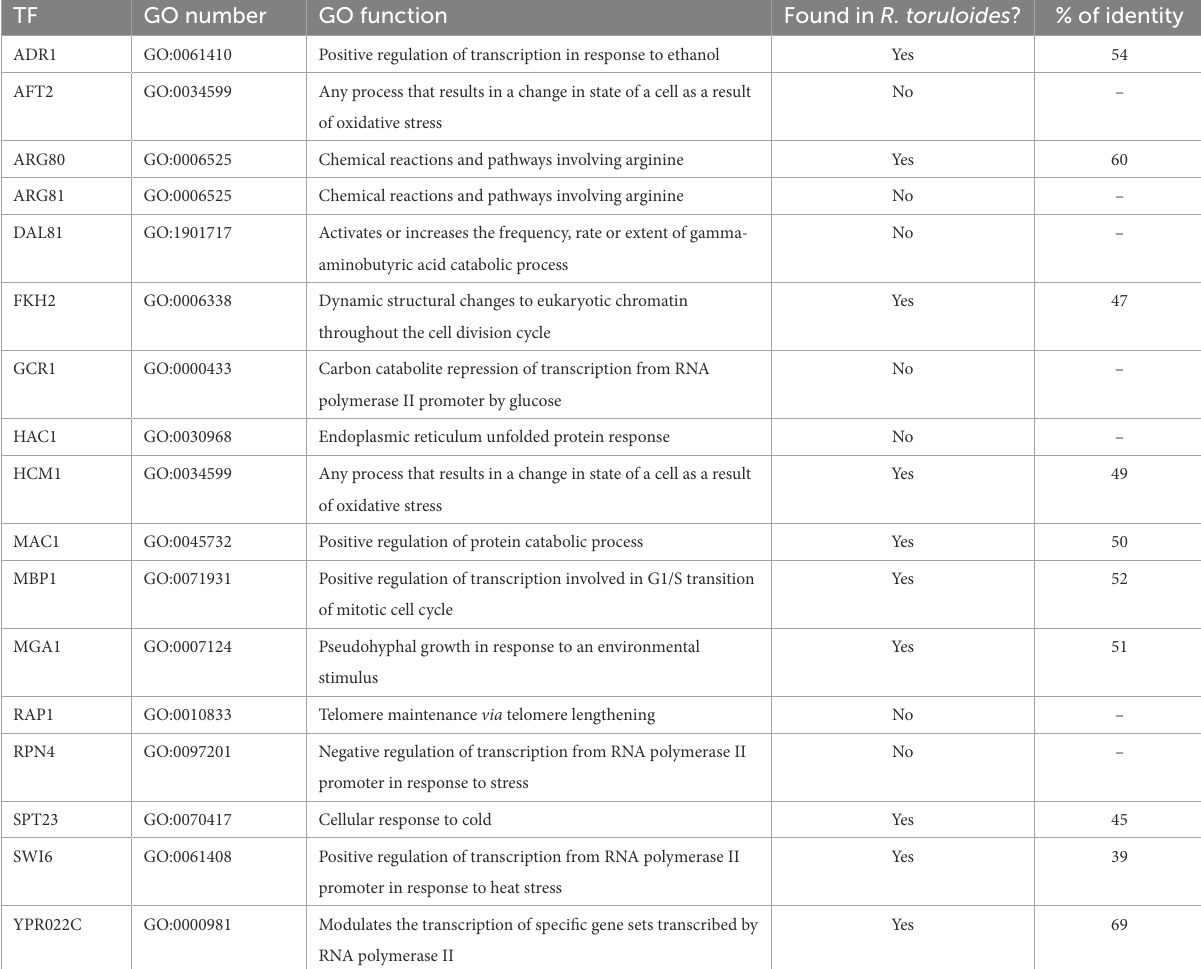
TABLE 2 Predicted transcription factors and their